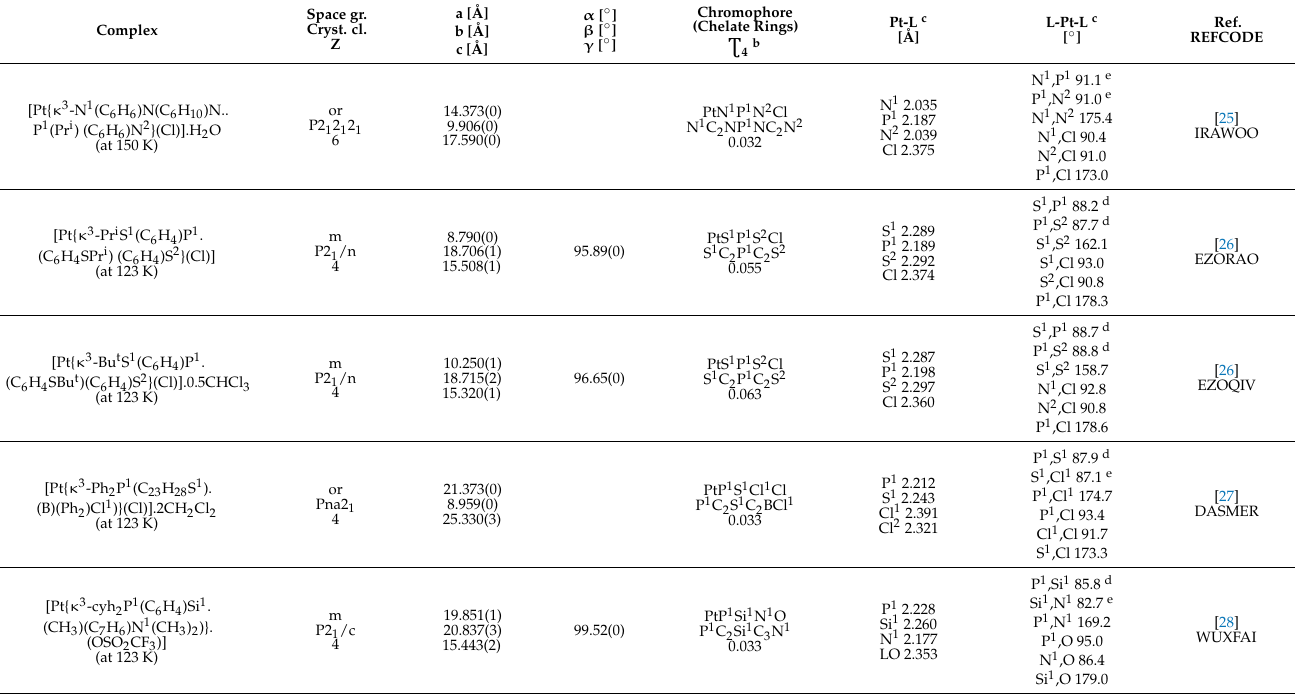
Table 2. Data for Pt( κ 3 –X 1 P 1 X 2 )(Cl), Pt( κ 3 –P 1 S 1 Cl 1 )(Cl) and Pt( κ 3 –P 1 Si 1 N 1 )(OL) derivatives mon- odentate atoms/ligands) a